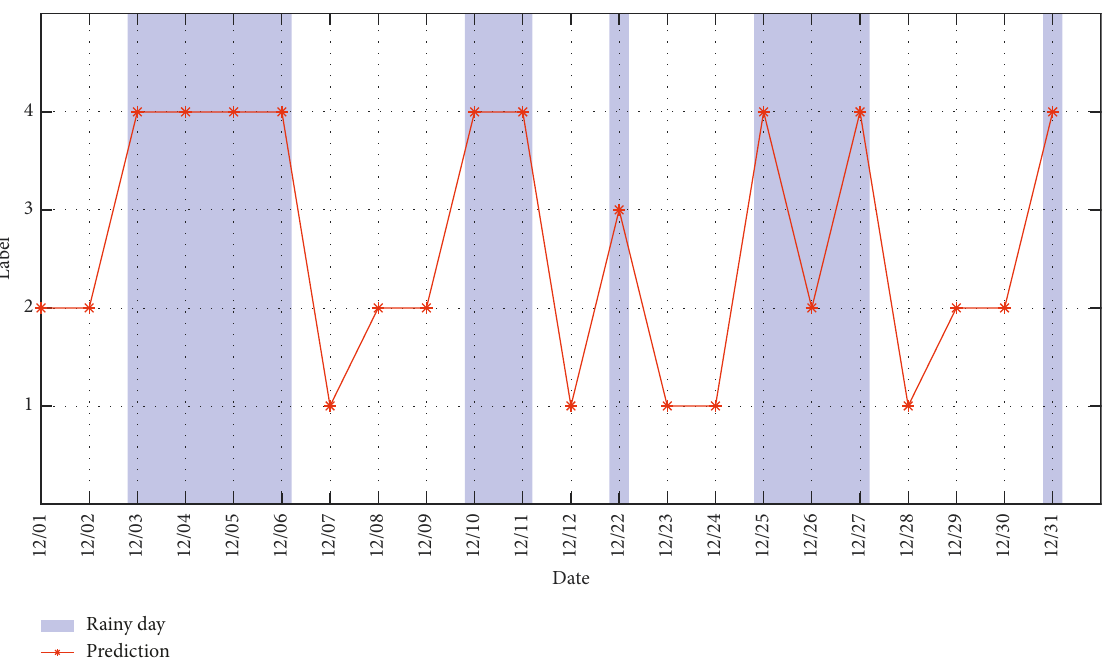
Figure 6: Classification effect of the rainy-day/rainless-day classifier.